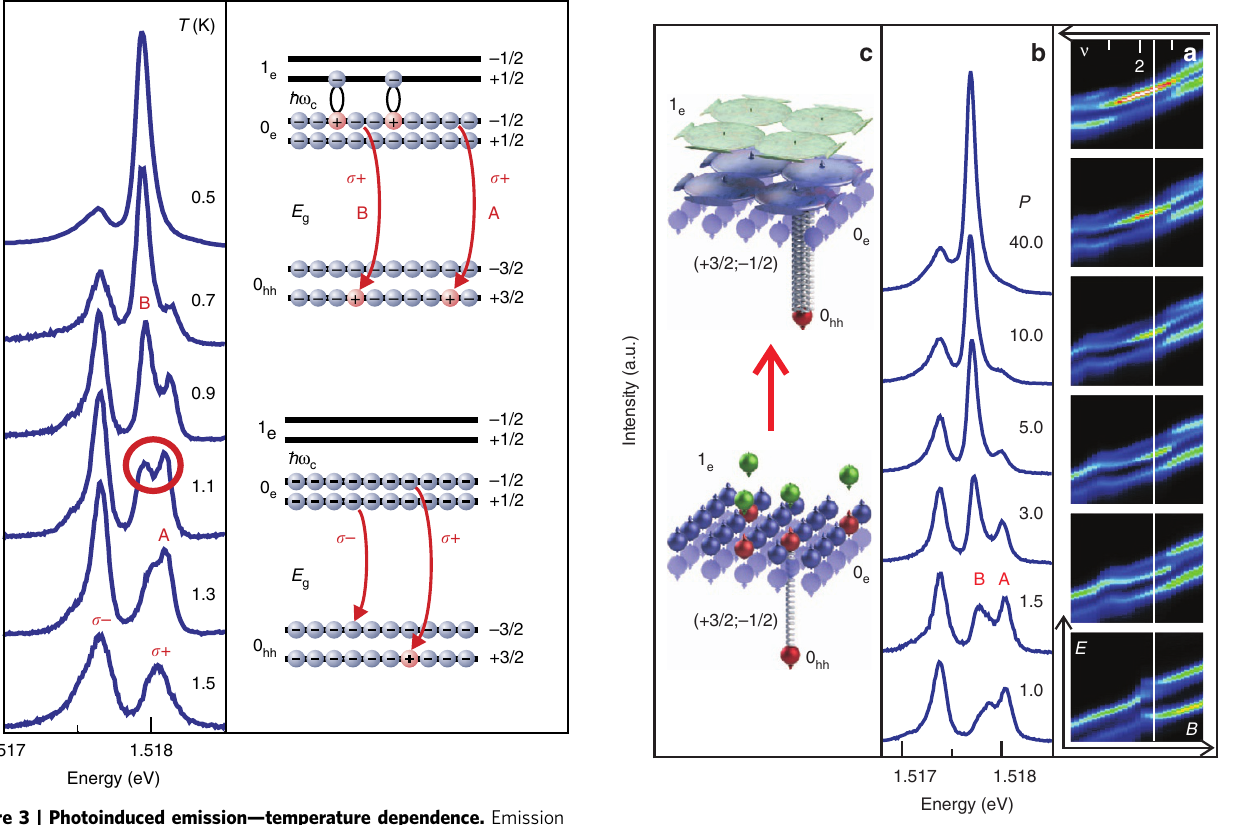
Figure 4 | Photoinduced emission—pumping power dependence. ( a ) Evolution of photoinduced emission spectra in magnetic field. No condensate occurs beyond the range of n ¼ 2 ± 0.15 indicated by the white ticks. The straight white line denotes the image cross-section shown in b (photoinduced emission spectra at fixed temperature of 0.5K and different photoexcitation powers P (in mWcm (cid:2) 2 )). The maxima of the optical transition in s þ polarization are shifted to a single-energy value. ( c ) Modification of the non-equilibrium electron system during formation of magnetofermionic